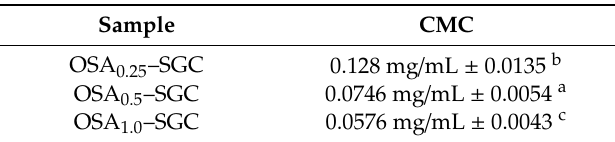
Figure 2. Critical micelle concentration (CMC) of OSA–SGC with a different degree of substitution (DS): ( A ) DS = 0.112, ( B ) DS = 0.286 and ( C ) DS = 0.342. Table 2. Critical micelle concentration of octenyl succinic anhydride short glucan chains with different degrees of substitution.